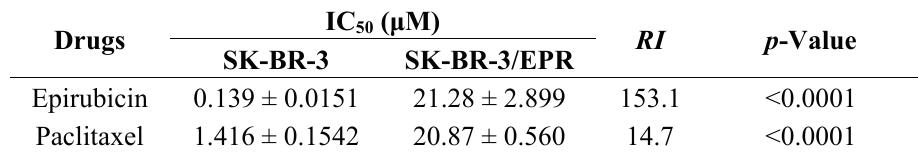
Table 2. IC 50 values in SK-BR-3 and SK-BR-3/EPR cells after sequential passages in epirubicin-free medium for six